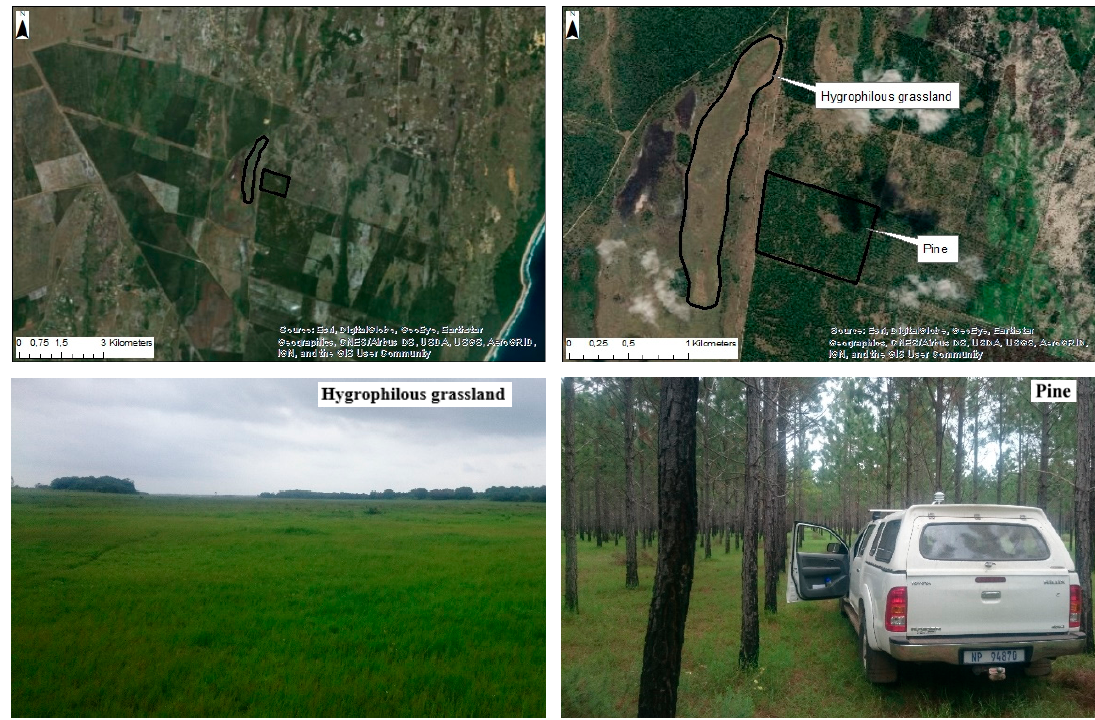
Figure 2. Hygrophilous grassland and pine survey sites.